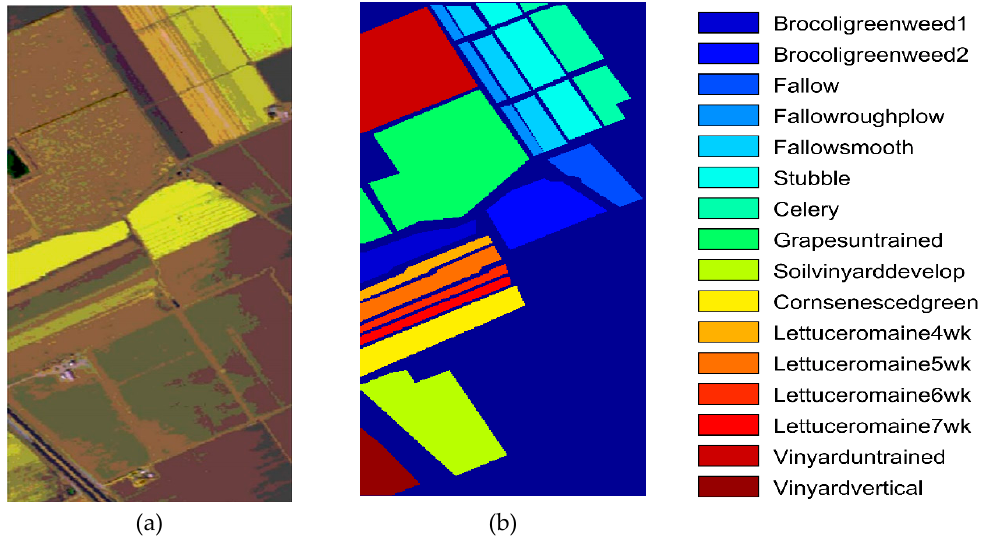
Figure 5. Salinas dataset. (a) False color image. (b) Ground ‐ truth.